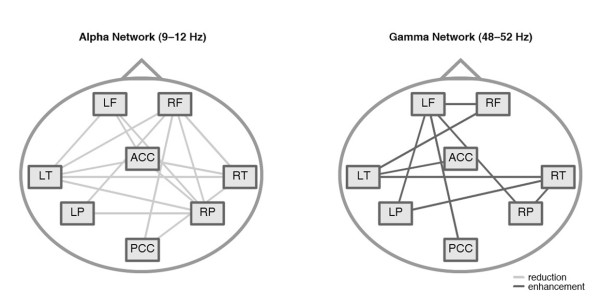
Schematic display of the alpha and the gamma network. Connections with a significant group difference were plotted as edges in the networks. The nodes were named by: LF = Left Frontal, RF = Right Frontal, LT = Left Temporal, RT = Right Temporal, LP = Left Parietal, RP = Right Parietal, ACC = Anterior Cingulate Cortex, and PCC = Posterior Cingulate Cortex.